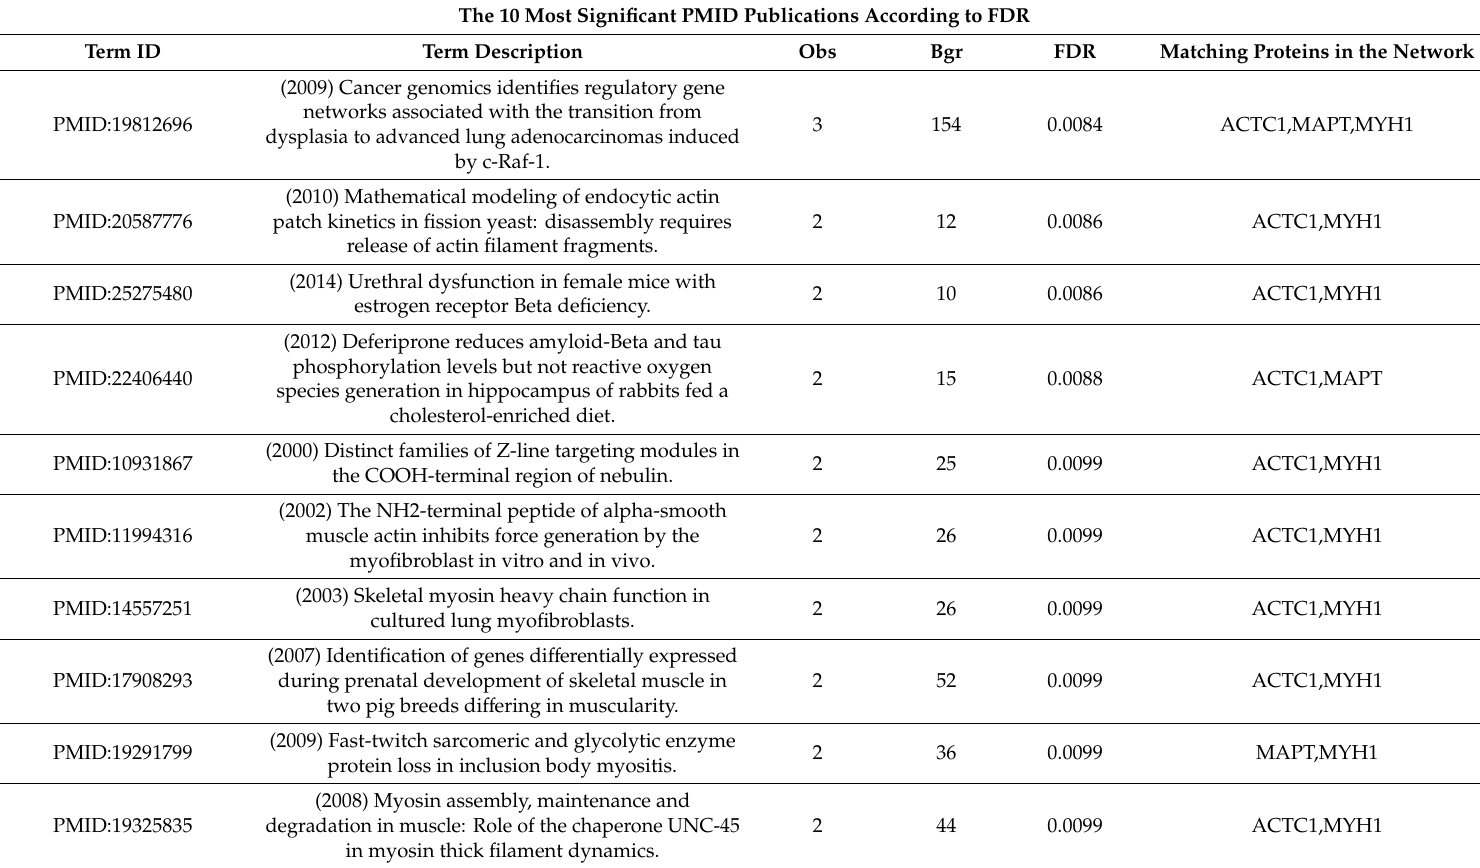
Table 7. PMIDs for the EV total unique proteins in the control group for the control vs. HIV comparison. The 10 Most Significant PMID Publications According to